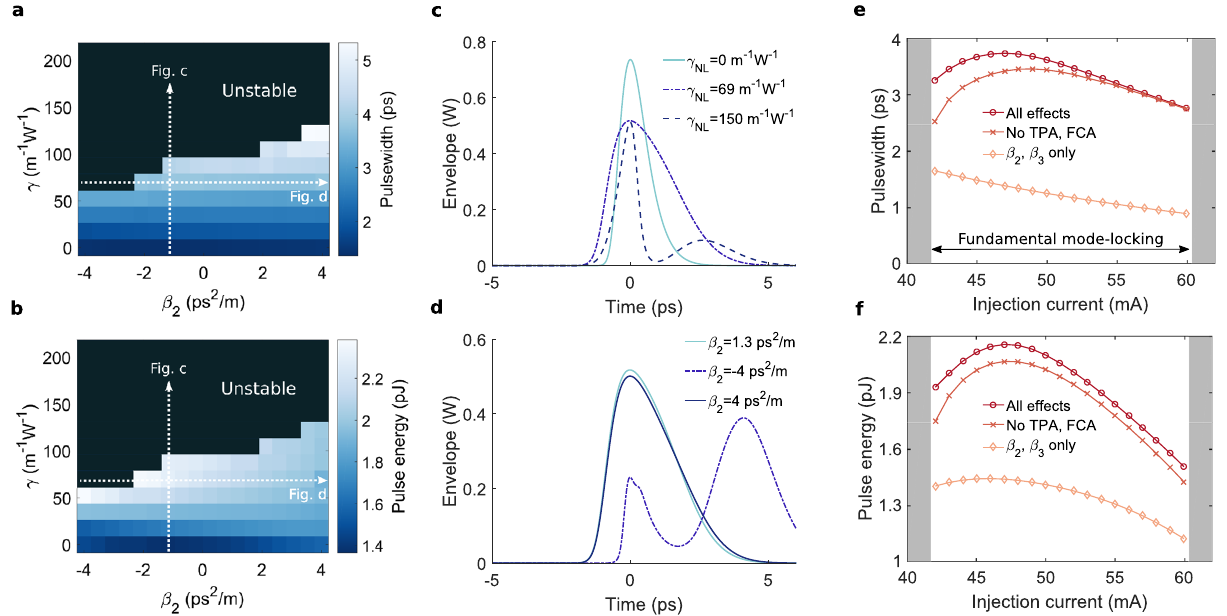
Figure 5. Impact of nonlinearity and dispersion of the extended passive laser cavity on the MLL performance and stability. Map of the pulse width ( a ) and pulse energy ( b ) as a function of GVD and Kerr nonlinearity. Stable fundamental mode-locking is predominantly observed for sufficiently small nonlinearities and normal dispersion. Output pulse for different nonlinearities and β 2 69m − 1 W − 1 ( d ). The corresponding operating regions on the maps ( a , b ) are indicated. Output pulse with γ NL = width ( e ) and pulse energy ( f ) as a function of injection current for γ NL